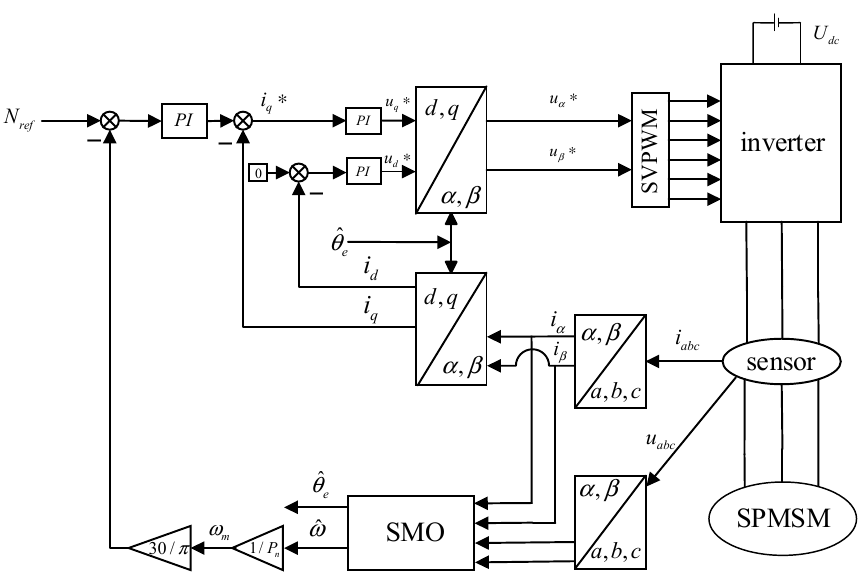
Figure 1. Block diagram of sensor-less control of the surface mounted permanent magnet synchronous motor based on improved SMO.